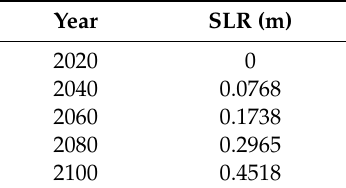
Table 1. SLRs [26]. Table 1. SLRs [26] .